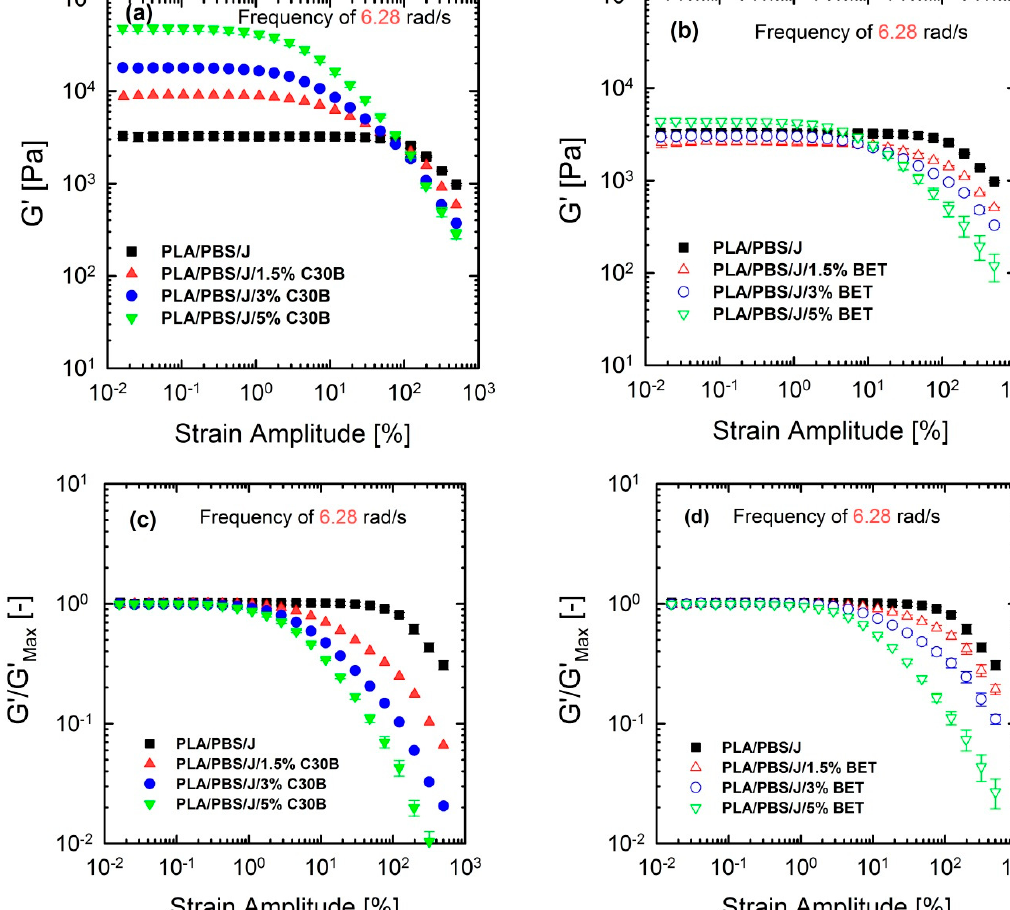
Figure 12. Storage (elastic) moduli G ’( γ 0 ) of the PLA/PBS/J blends, for various loadings of ( a ) C30B and ( b ) BET, at 190 ° C, under the LAOS flow and a fixed frequency of 6.28 rad/s. ( c , d ) represent the normalized moduli of the their counterpart plots in ( a , b ). BET is Betsopa™, C30B is Cloisite ® 30B, and J is Joncryl.